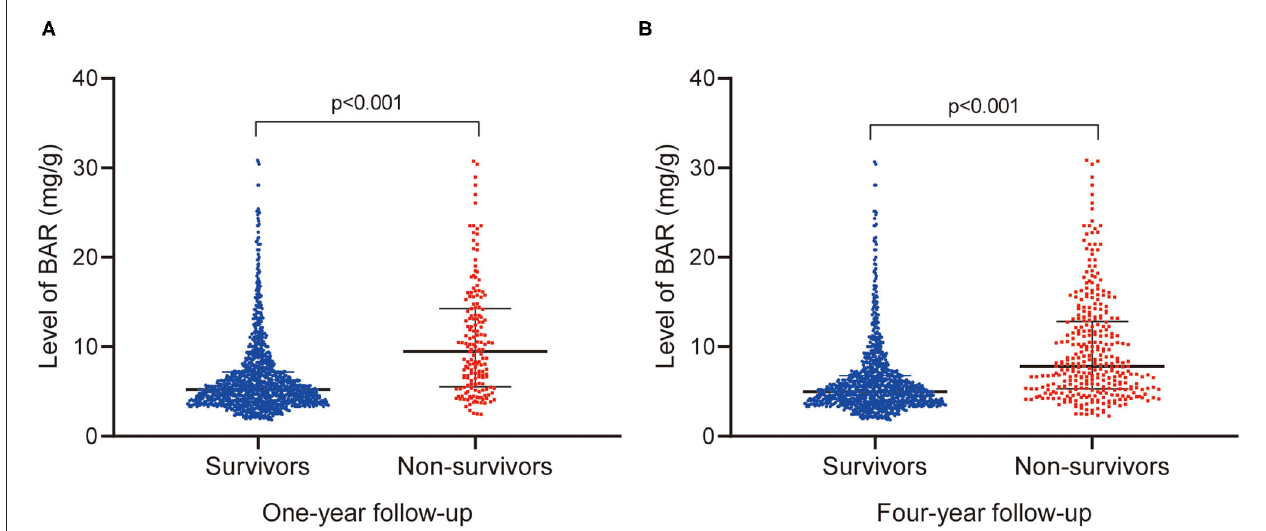
FIGURE 2 | Comparison of BAR levels between survivors and nonsurvivors at 1- (A) and 4-year (B) follow-up. BAR, blood urea nitrogen-to-albumin